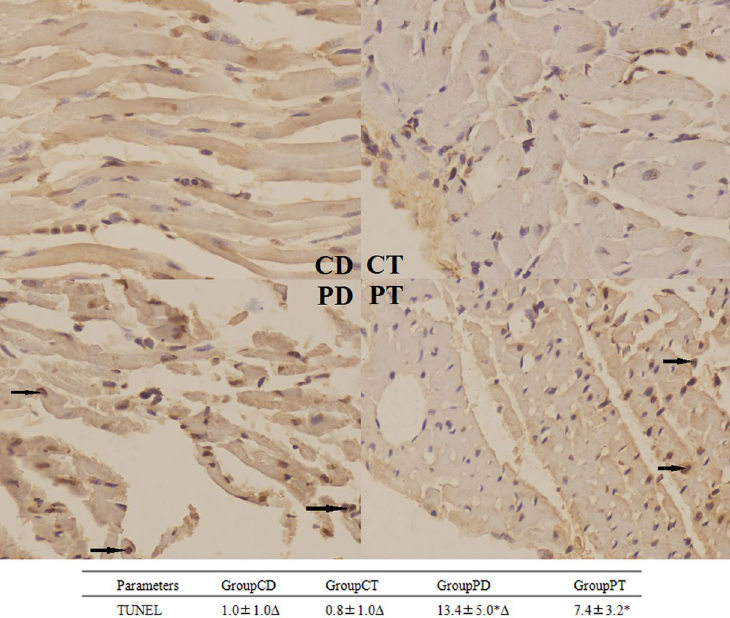
Figure 3. TUNEL staining of the right ventricular myocardium. The arrows indicate apoptotic cells (400X). (CD: rats treated with NS + DMSO, CT: rats treated with NS + T0901317, PD: rats treated with MCT + DMSO, PT, rats treated with MCT + T0901317). (n = 6, * p < 0.05 compared to the CD group, Δ p < 0.05 compared to the PT